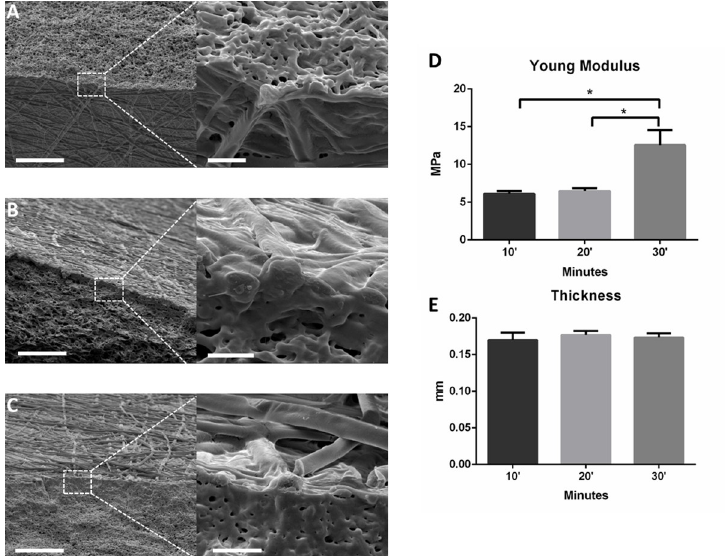
Fig 3. Different production times of electrospun PLA fibers added on a PLC organogel film. FE-SEM cross section images of production PLA fibers on the organogel PLC film during A) 10 minutes, B) 20 minutes and C) 30 minutes (scale bars = 30 microns. Inserts: scale bar = 3 microns). D) Young Modulus and E) thickness measurements of the different conditions (n = 3, � P < 0.05).